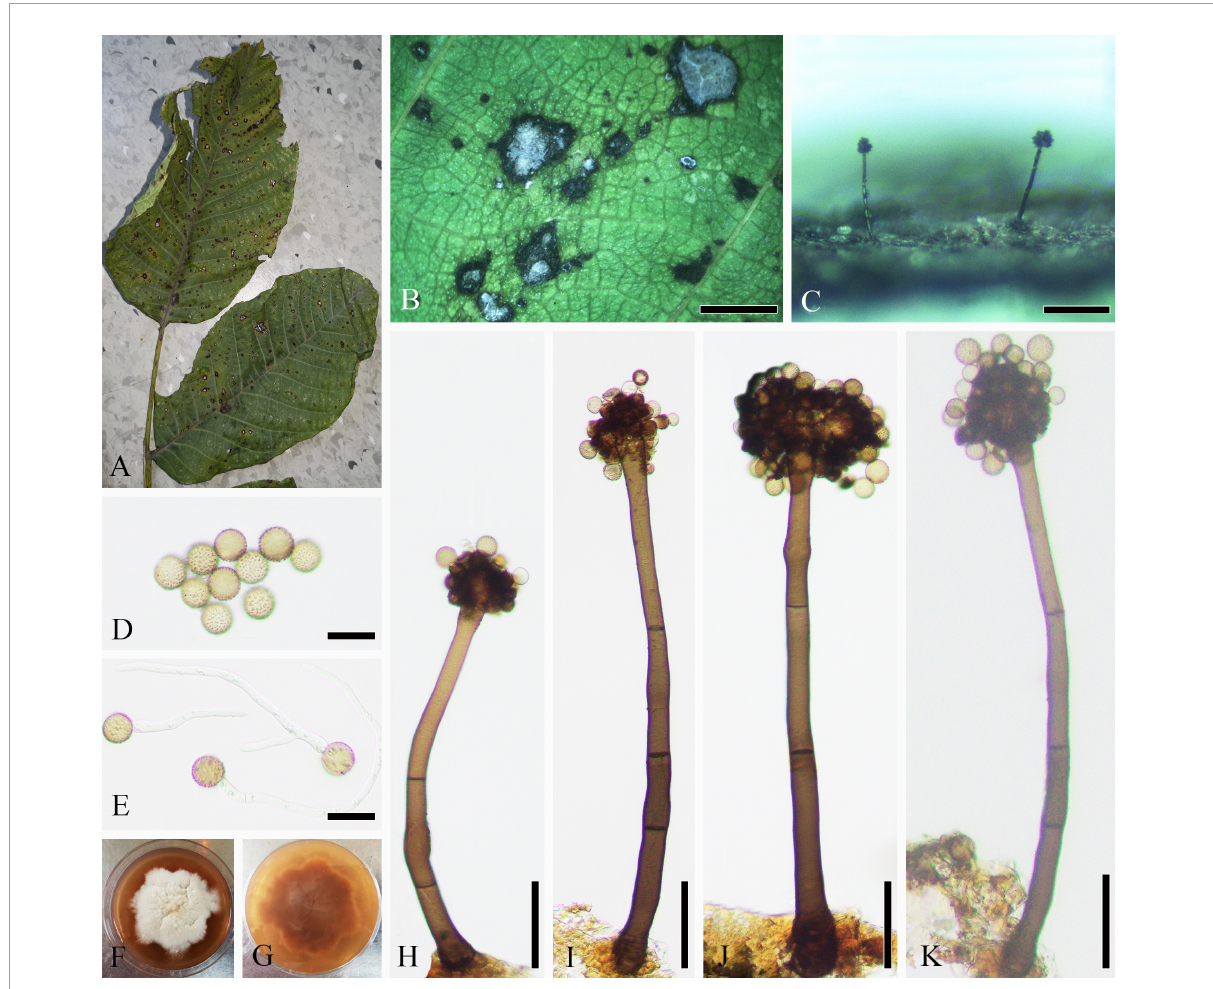
FIGURE9 Periconia byssoides (SICAU 22-0106). (A,B) Symptoms of leaf spots observed on host. (C) Close-up of colonies on substrate. (D) Conidia. (E) Germinating conidia. (F,G) Colonies on PDA for 25 days. (H–K) Conidiophores. Scale bars: (B) 2,000 µ m, (C) 200 µ m, (D,E) 20 µ m, and (H–K) 50 µ m.